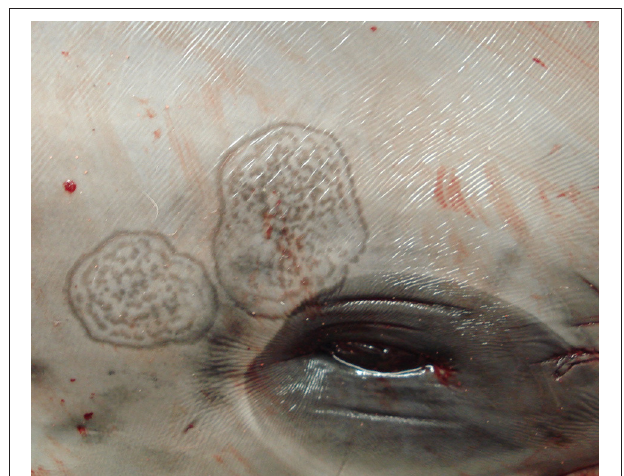
FIGURE 1 | Skin lesions. Stenella coeruleoalba . (case 1). Wide, multifocal to coalescing, lightly gray areas with dark edges and stippled in the center, affecting the head.